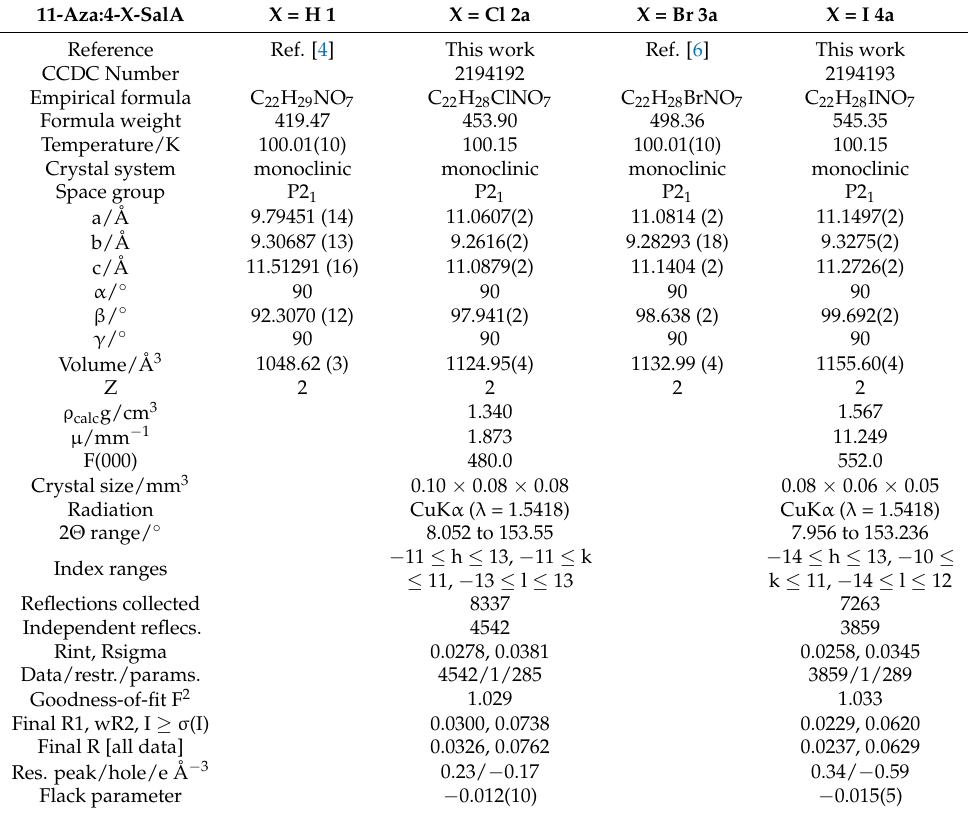
Table 1. Crystal Data Summaries for 1 , 2a , 3a and 4a , monoclinic polymorph type-I.